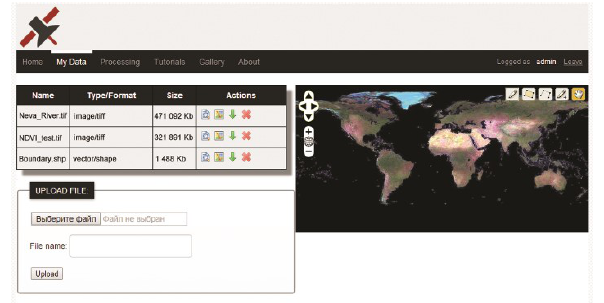
Figure 7. Web interface of the personal